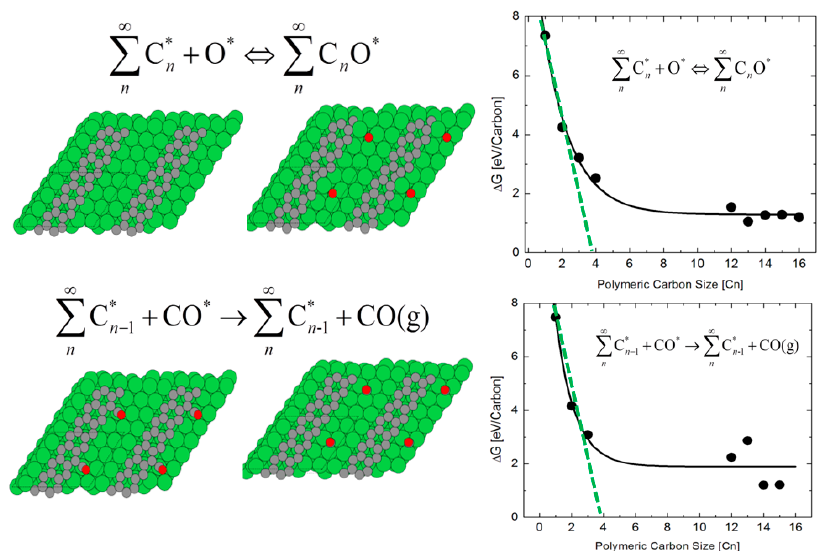
Figure 12. Intermediate steps in the direct carbon monoxide formation mechanism and their free energy profiles for implementing a reactive burn-off.